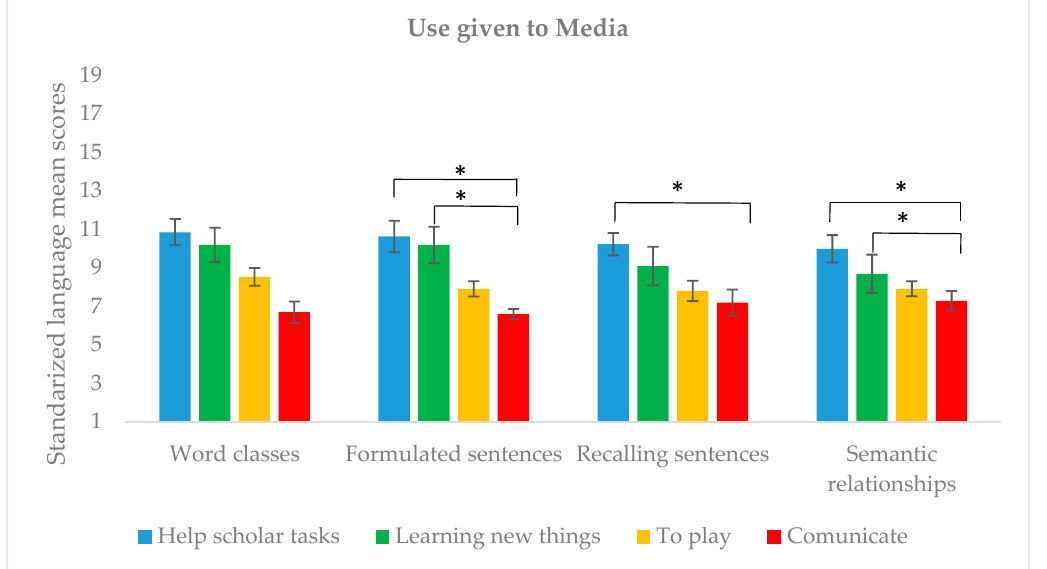
Figure 3. Mean language scores and main use of media. * p < 0.01.